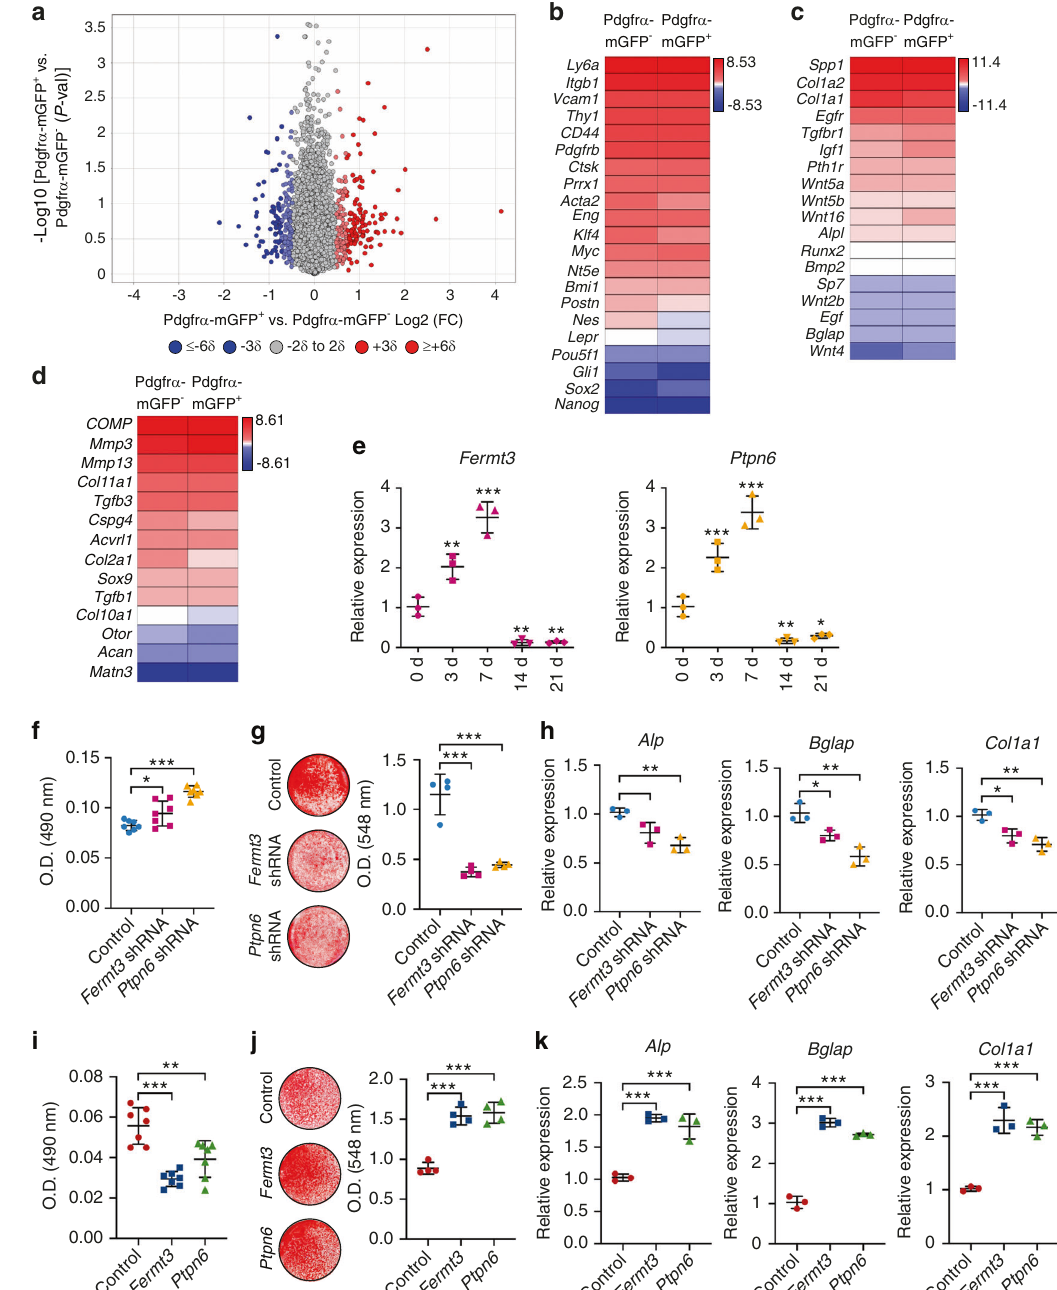
Fig. 7 Fermt3 and Ptpn6 gene enrichment underlies the osteoblastic phenotype of PDGFR α reporter + periosteal cells. a – d Total RNA sequencing comparison between PDGFR α reporter − CD31 − CD45 − Ter119 − and PDGFR α reporter + CD31 − CD45 − Ter119 − cells from the mouse periosteum of PDGFR α mT/mG animals. a Volcano plot of all transcripts. The x -axis represents the log2(fold change) for each gene. The y -axis represents the -log10( P value). The red dots indicate a > 2 SD increase among PDGFR α reporter + periosteal cells, and the blue dots indicate a > 2 SD increase among PDGFR α reporter − periosteal cells. b Heatmap demonstrating the mRNA expression levels of stemness- and stem cell- related markers among PDGFR α reporter + and PDGFR α reporter − periosteal cells. Heatmap of the expression of ( c ) osteogenic gene markers and ( d ) chondrogenic gene markers among PDGFR α reporter + and PDGFR α reporter − periosteal cells. e Relative expression of Fermt3 and Ptpn6 at the indicated time points during osteogenesis detected by qRT – PCR. The differences are shown in comparison to the initial expression (at d 0). f Cell proliferation of PDGFR α reporter + periosteal cells with or without Fermt3 or Ptpn6 shRNA determined by MTS assays (48 h). Osteogenic differentiation of PDGFR α reporter + periosteal cells with or without Fermt3 or Ptpn6 shRNA assessed ( g ) by Alizarin Red (AR) staining (11 d) and ( h ) based on the expression of osteogenic genes, including alkaline phosphatase ( Alp ), osteocalcin ( Bglap ), and collagen type 1 a1 ( Col1a1 ) (7 d), measured by qRT – PCR. i Cell proliferation of PDGFR α reporter − periosteal cells with or without Fermt3 or Ptpn6 overexpression measured by MTS assays (48 h). Osteogenic differentiation of PDGFR α reporter − periosteal cells with or without Fermt3 or Ptpn6 overexpression assessed ( j ) by AR staining (8 d) and ( k ) based on osteogenic gene expression determined by qRT – PCR (7 d). The dot plots represent an individual sample, and the whisker plots indicate the mean and one-SD values. * P < 0.05, ** P < 0.01 and *** P < 0.001, as assessed by one-way ANOVA with Tukey ’ s multiple-comparisons